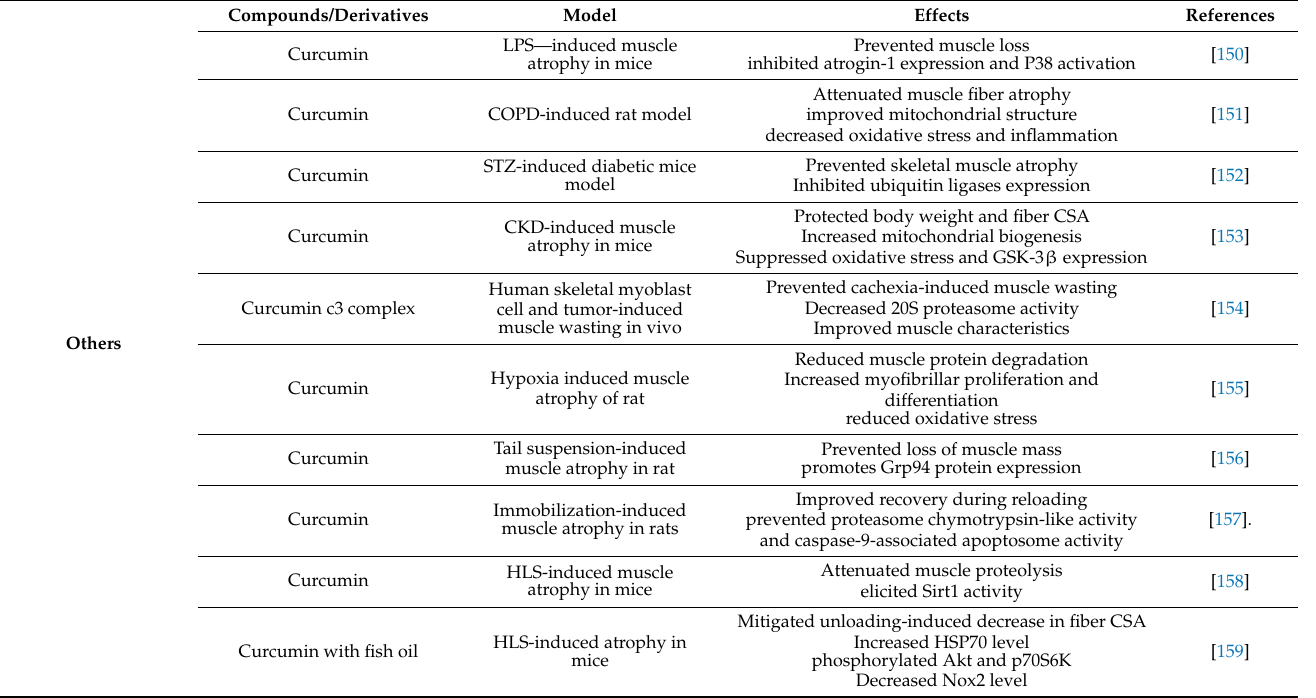
Table 5. Function of other polyphenols and in promotion of muscle health and prevention of muscle atrophy.